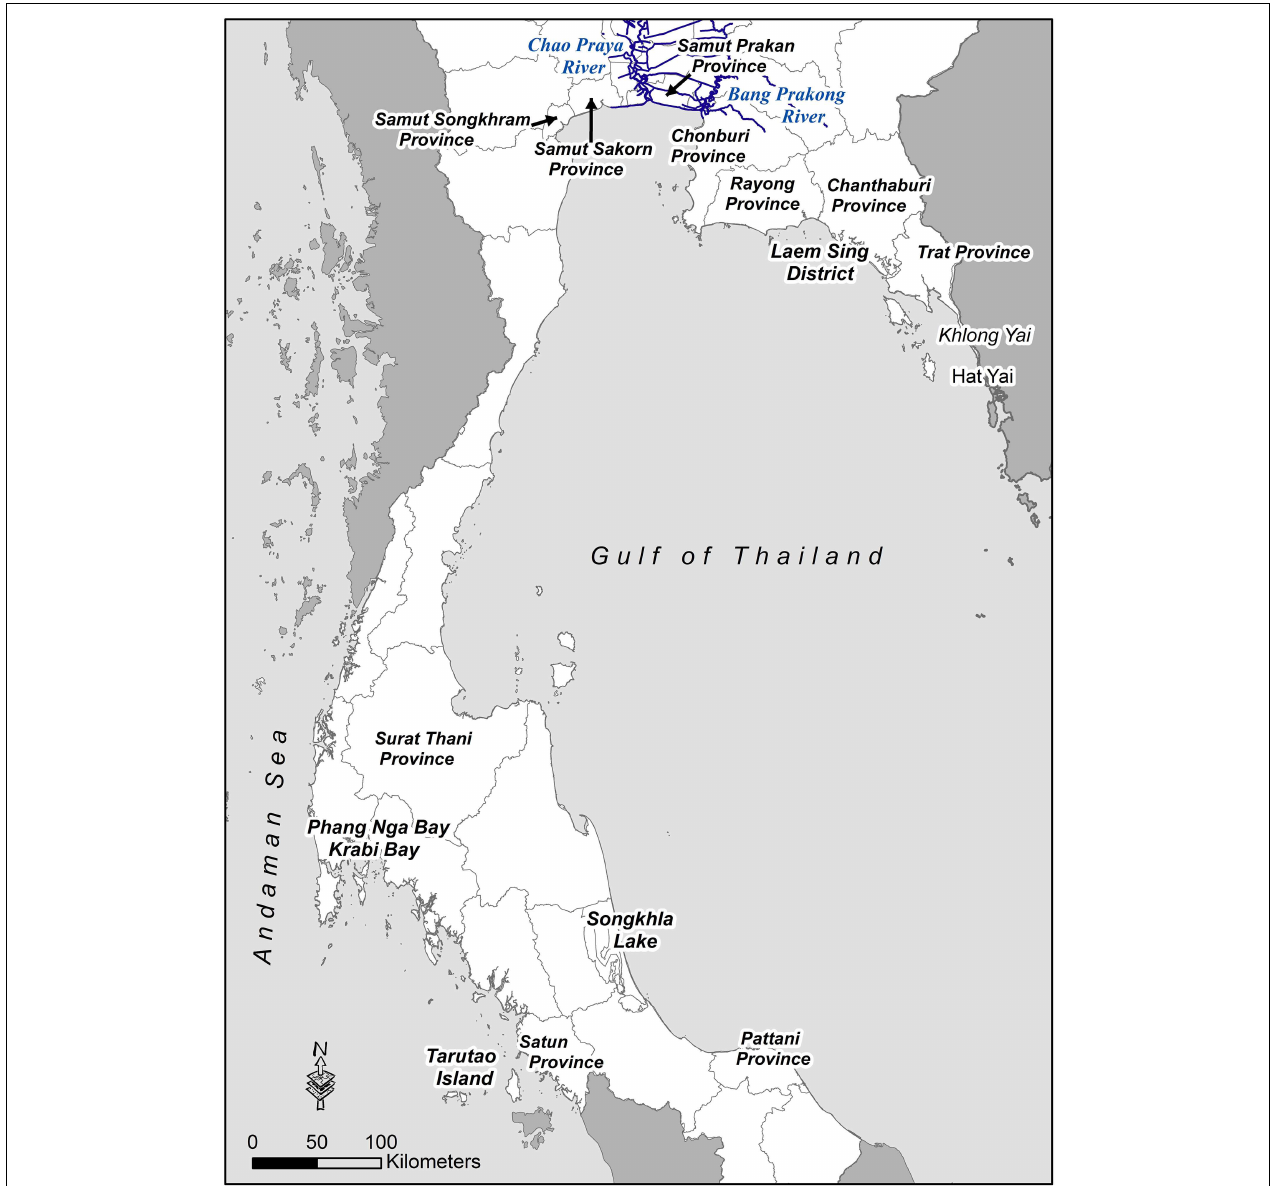
FIGURE 1 | Map of Thailand with Irrawaddy dolphin sighting areas mentioned in the